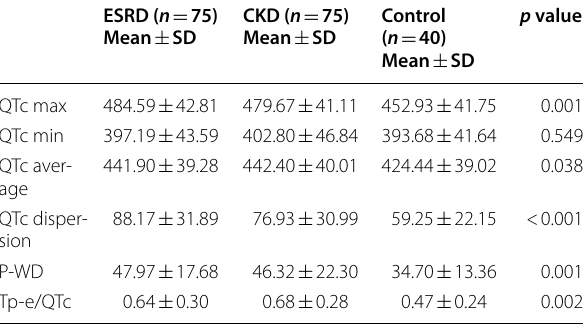
Patients with ESRD had significantly higher QTc max, QTc dispersion, and P-WD when compared to the other 2 study groups, Table 2. Comparison between patients with ESRD and patients with CKD showed non-significant differences except for levels of urea ( p 0.002), creatinine ( p < 0.001), PO4 = ( p 0.016) and PTH ( p 0.002) which were higher in the = = ESRD group, while serum calcium level ( p 0.023) was = significantly lower in the ESRD group. Subgroup analysis of patients with ESRD showed that males had a significantly higher P-WD values ( p 0.045), insignificantly higher QTc dispersion = ( p 0.445), and insignificantly lower Tp-e/QT ratio = ( p 0.252) when compared to females. While in the = CKD group, only the Tp-e/QT ratio was significantly higher in males, Table 3. ESRD hypertensive patients showed a significantly lower P-WD when compared to ESRD normotensive individuals, Table 3. On the other hand, patients with DM did not show any significant difference of the ECG parameters neither in the ESRD nor in the CKD patients as compared to non-diabetic patients. Multivariate linear regression analysis of ESRD patients showed that serum creatinine ( β 0.279, p 0.012) = = and were independent predictors of increased QTc dis- persion while ejection fraction ( β 0.320, p 0.002), = =